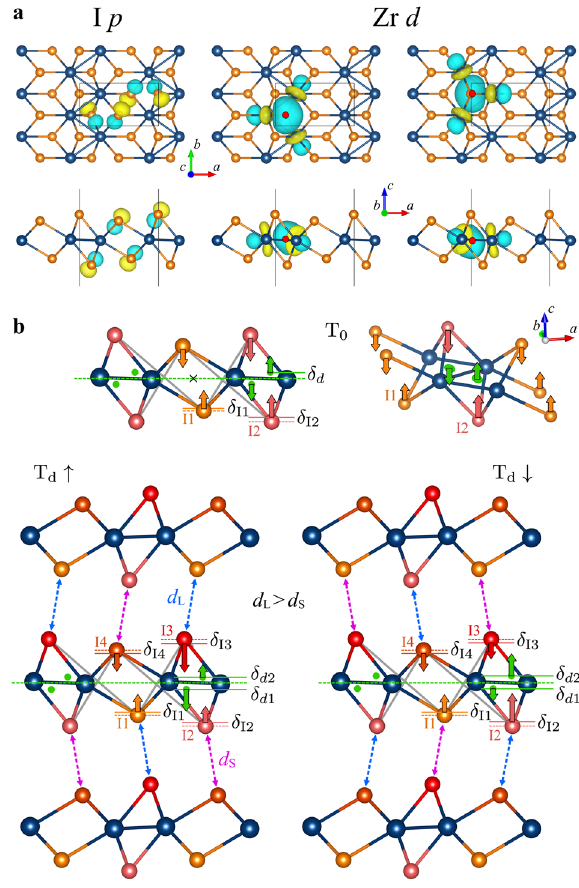
Fig. 3 Schematics of electronic charge displacements in ZrI 2 . a Wannier functions (top and side views) constructed for the occupied I p (left) and Zr d (middle and right) states. The Wannier functions are presented for one trilayer, and only one p Wannier function at each I site is shown for clarity. Centers of the d orbital Wannier functions are denoted with red circles. b Electronic charge displacements in the centrosymmetric and non-centrosymmetric phases due to interlayer sliding. Vertical shifts of the Wannier centers off their speci fi ed atomic positions are schematically shown with arrows. Centers of the d orbital Wannier functions are denoted with green circles. The alternating longer d L and shorter d S zigzag I – I bonds are shown with blue and pink colours, respectively. The inversion center is marked with the black